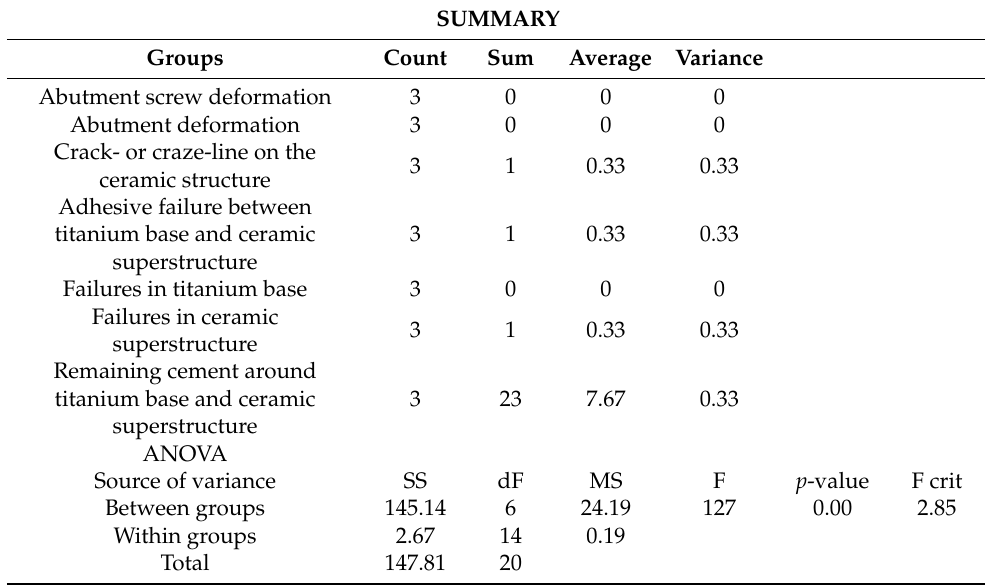
Table 4. Comparison across seven analysis techniques (single-factor